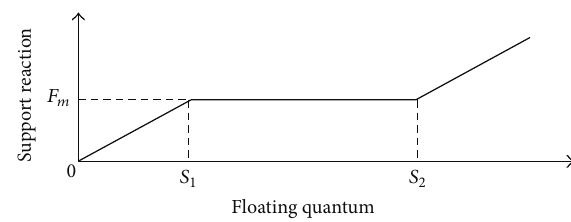
Figure 9: Supporting rigidity for floating